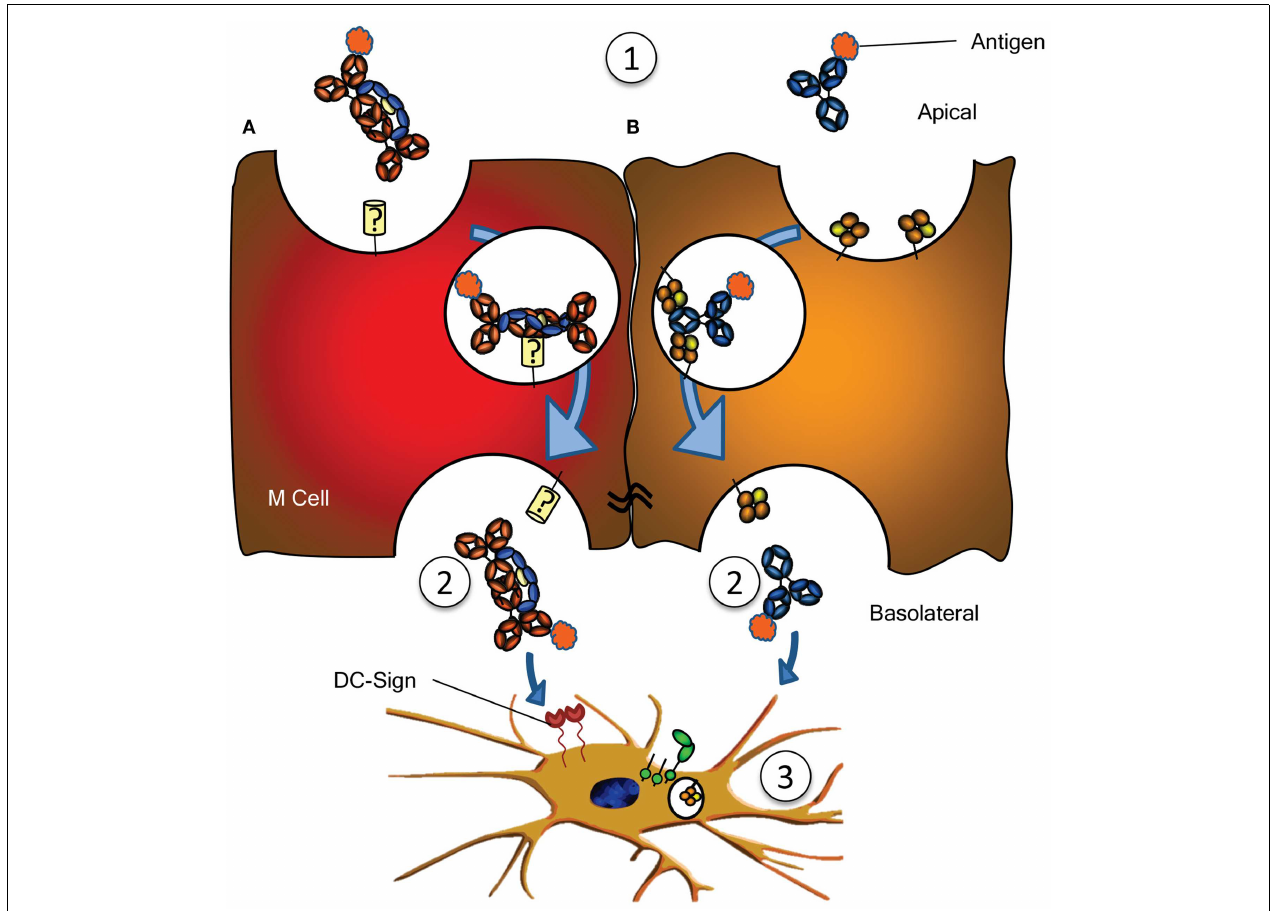
can traverse the epithelial layer through FcRn-depended transcytosis and taken up by DCs through Fc γ R and FcRn (2) (73). Both IgG- or IgA-mediated antigen uptake can enhance antigen presentation, subsequent activation and proliferation of antigen-specific B- andT cells, boosting immune responses (3). See text for more